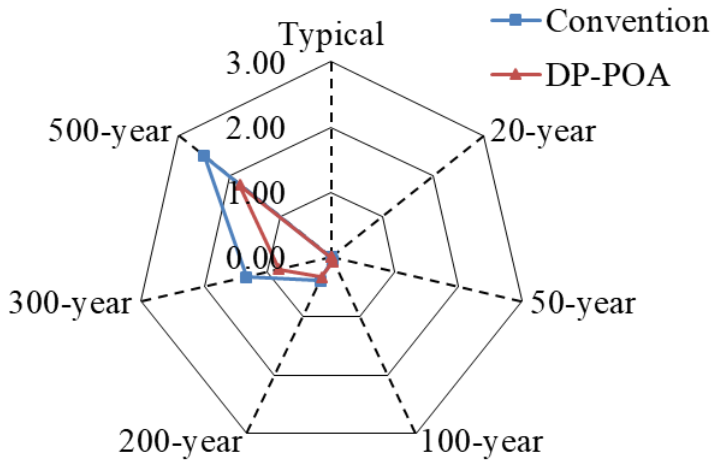
Figure 8. The average flood diversion volume of the Quangang flood storage for typical and design floods.